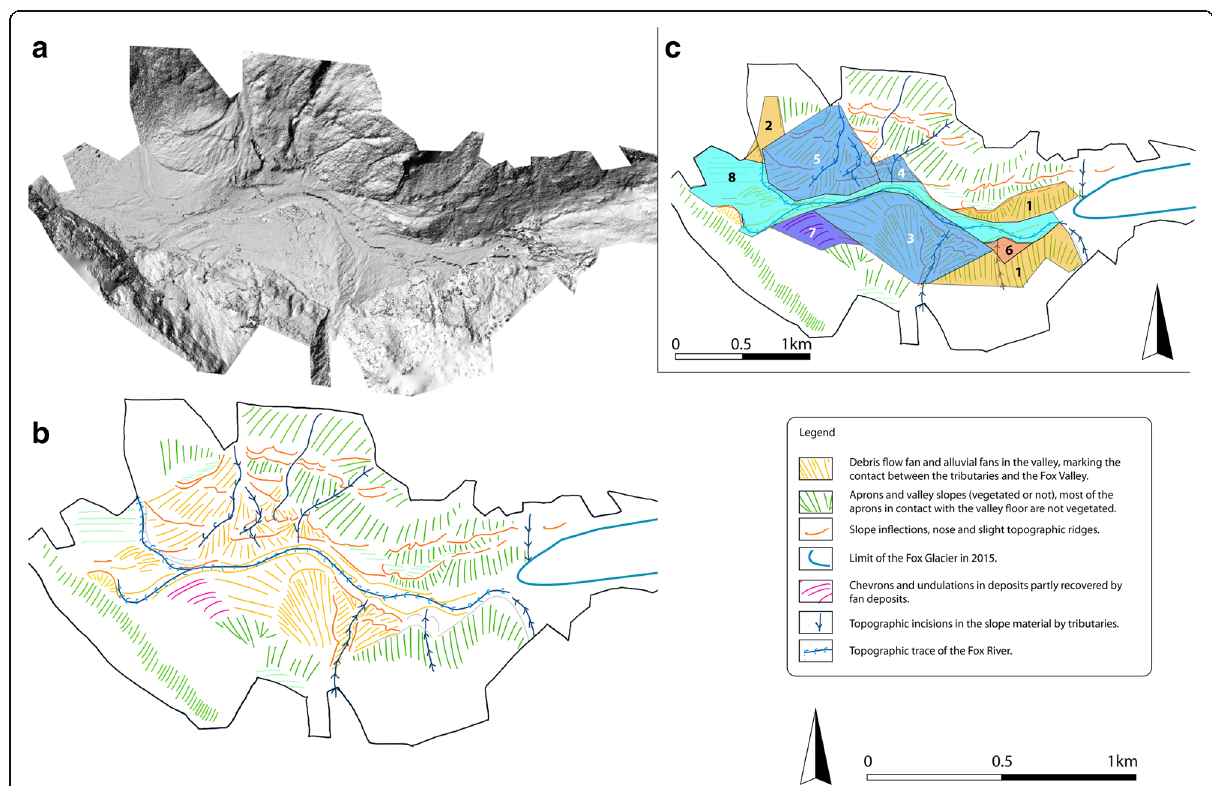
Fig. 5 Geomorphological mapping of the valley below Fox Glacier. a Shaded relief map generated from the UAV and helicopter-based photogrammetry. b Geomorphological map with the principal landforms and their break locations. c The principal landform units in the valley. Unit (1) unvegetated material plastered by the glacier, unit (2) rockfall and debris cone, units (3 – 5) the main fans of the valley, unit (6) a mix of debris flow fan and apron material, unit (7) undertermined wavy feature being recovered by the recent fan extension, and unit (8) braided-river fluviatile